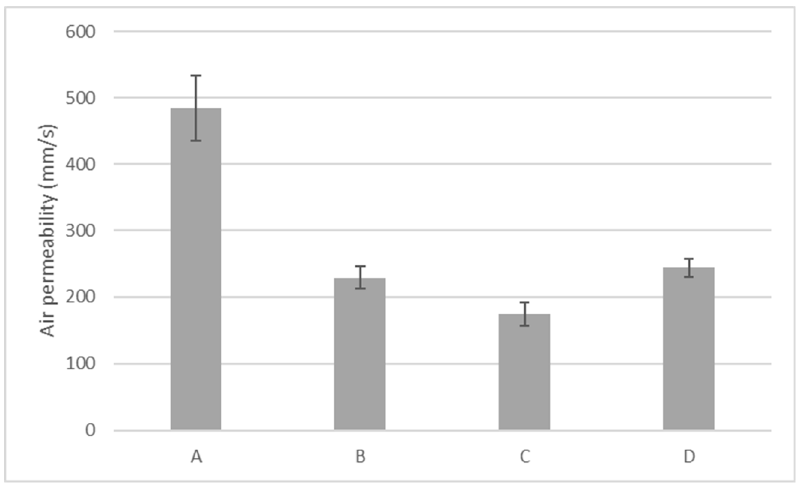
Figure 1. Air permeability (mm/s).